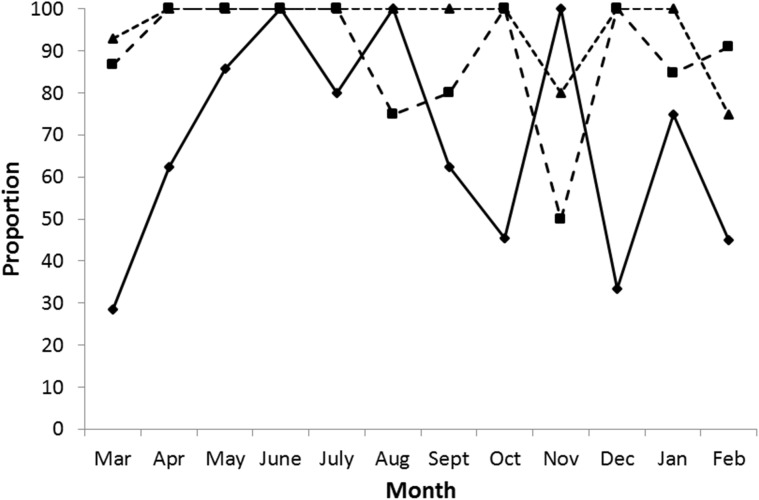
Effect of age on corpora lutea occurrence in each month.The percentage of each age class carrying corpora lutea by month: yearlings—diamond marker, adults—square marker and aged adults—triangular marker.